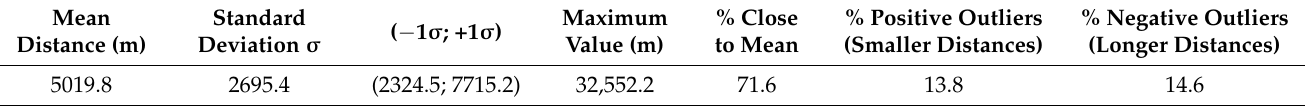
Table 2. Main statistics on the value of distance to PHC facilities.